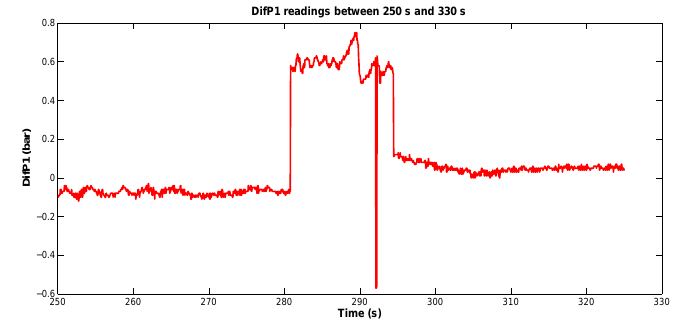
Figure 11. DifP1 readings between 250 s and 330 s. Source: By authors.